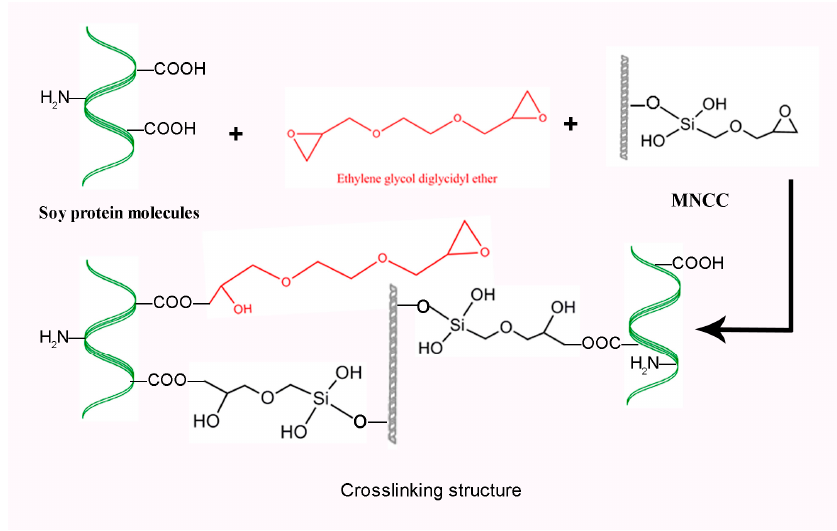
Schematic illustration of the reaction mechanism of EGDE, MNCC, and soy protein